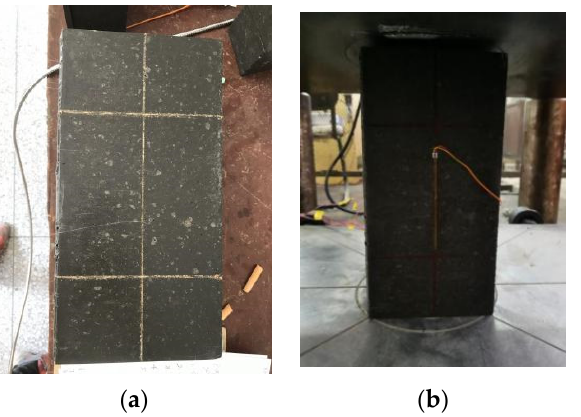
Figure 6. Test specimen and procedure of the elastic modulus test. ( a ) Test Specimen; ( b )Test pro- cess